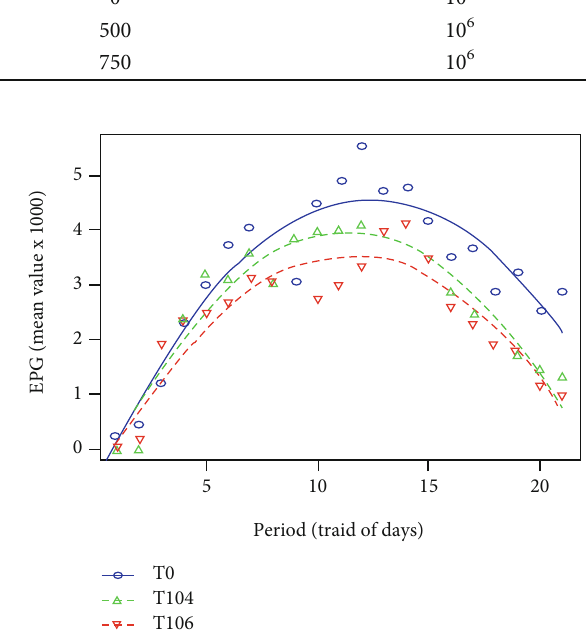
Figure 1: Ascaridia galli fecal eggs (EPG) according to Salmonella typhimurium concentrations and time. T